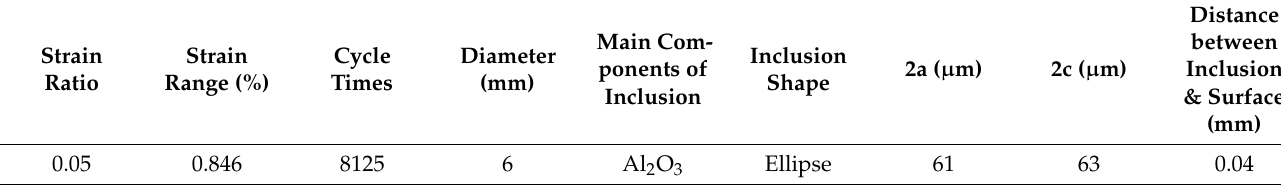
Table 1. Experimental data of specimen No.